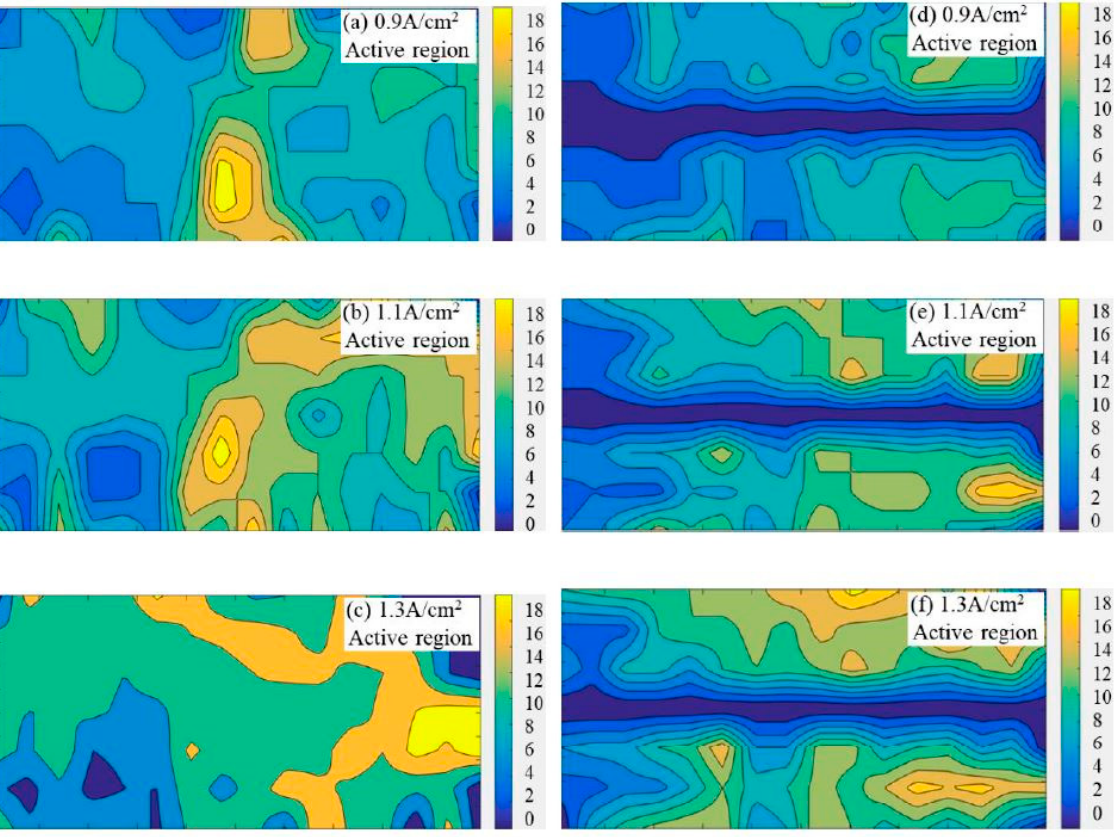
Figure 4. The bubble generation patterns on the flat and slotted anodes from statistical analysis within 60 s, the gradient bars indicate the number of newly generated bubbles on the specific anode surface within 60 s. ( a ) Apparent current density 0.9 A ‧ cm − 2 , flat anode ( b ) 1.1 A ‧ cm − 2 , flat anode ( c ) 1.3 A ‧ cm − 2 , flat anode ( d ) 0.9 A ‧ cm − 2 , slotted anode ( e ) 1.1 A ‧ cm − 2 , slotted anode ( f ) 1.3 A ‧ cm − 2 , slotted anode.